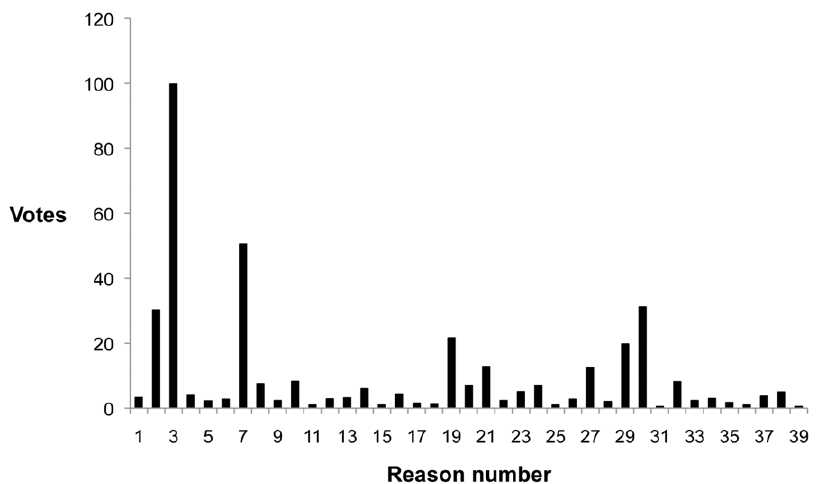
Figure 2. Number of votes per ‘reason’ for survey Q4. Question 4: In procedures resulting in painful outcomes for the animals, should pain relief always be provided?